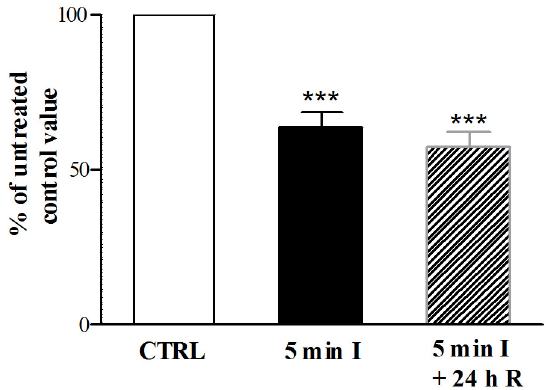
Figure 2. Effect of I/R damage on myenteric neuron number. Bars indicate the percentage variation of the number of rat small intestine myenteric neurons staining for HuC/D after inducing chemical ischemia (black) and after 24 h of reperfusion (slash) with respect to values obtained in normal metabolic conditions (empty). Values are expressed as mean ¡ SEM of four experiments. Vertical bars indicate SEM *** P , 0.001 by one way ANOVA followed by Tukey’s test post hoc